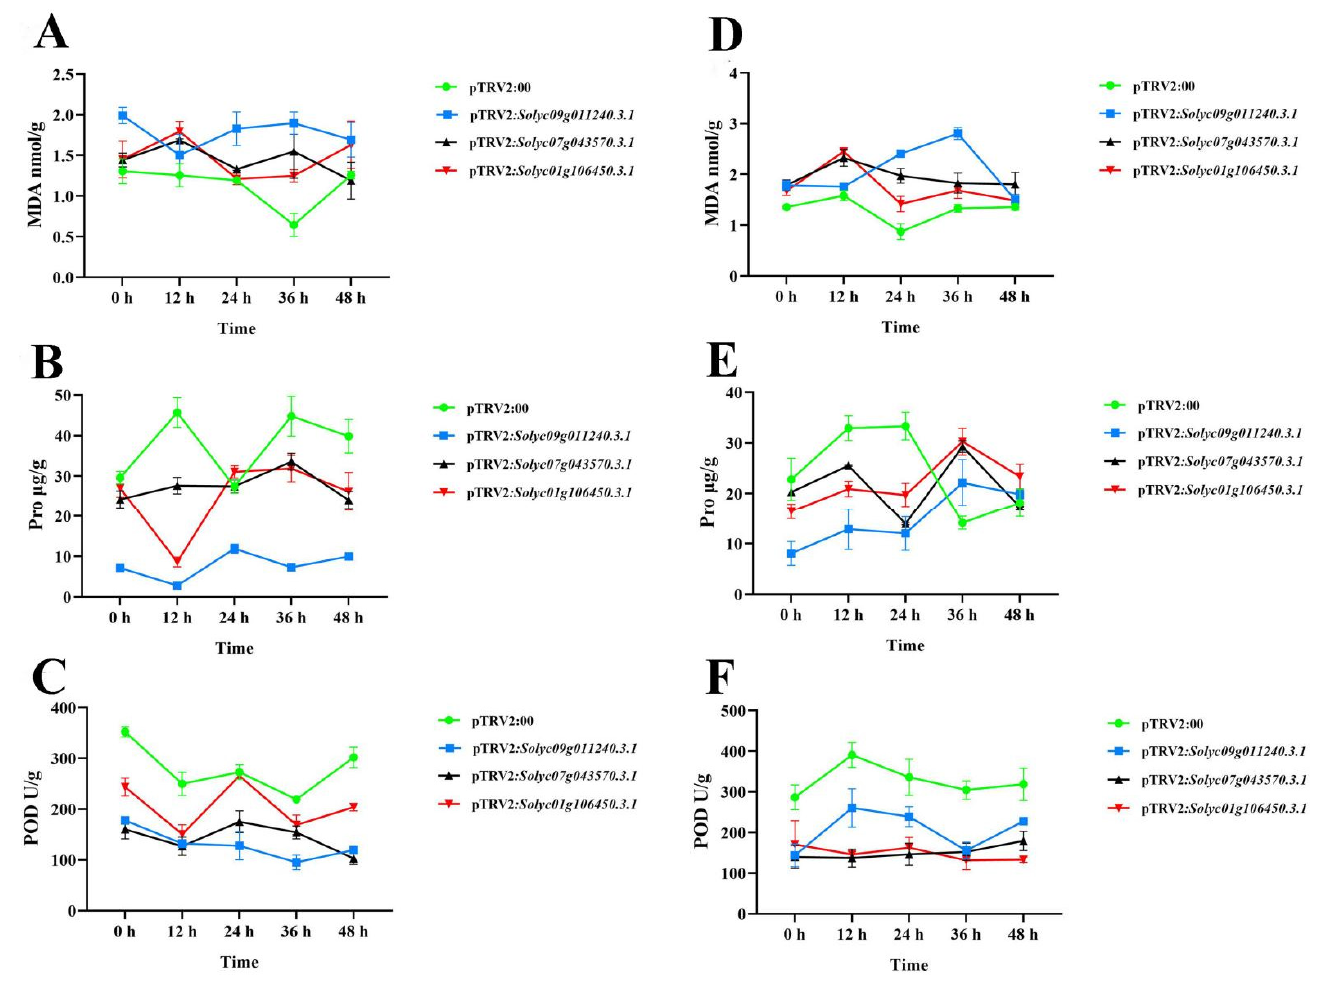
Figure 10. Physiological indicators of silenced transgenic tomato lines under drought and salt stresses for 0, 3, 6, 12, 24, 36, and 48 h with AC as control. The MDA contents ( A ), the Pro activities ( B ), and the POD activities ( C ) of transgenic tomato lines, including pTRV2: Solyc09g011240.3.1 , pTRV2: Solyc07g043570.3.1 , and pTRV2: Solyc01g106450.3.1 under 10% PEG stresses for 0, 3, 6, 12, 24, 36, 48 h with AC as control. The MDA contents ( D ), the Pro activities ( E ), the POD activities ( F ) of transgenic tomato lines, including pTRV2: Solyc09g011240.3.1 , pTRV2: Solyc07g043570.3.1, and pTRV2: Solyc01g106450.3.1 under 200 mM NaCl stresses for 0, 3, 6, 12, 24, 36, and 48 h, with AC as control.